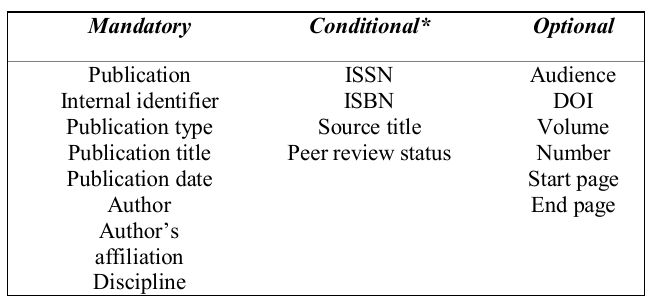
Table 1 . Proposed metadata for the European Publication Information